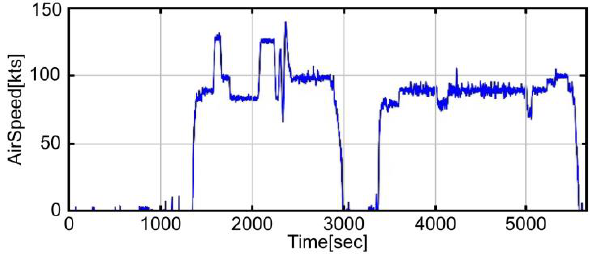
Figure 3. Airspeed.